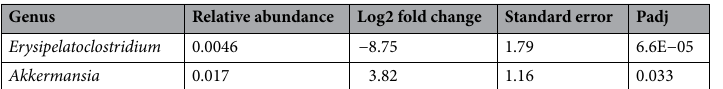
Table 5. DESeqQ2 genus level data comparing post-intervention to pre-intervention.